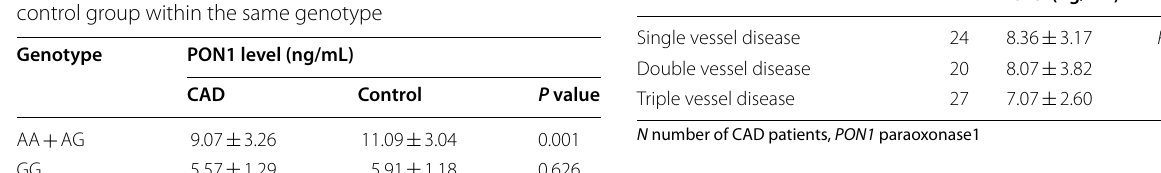
standard deviation, PON1 paraoxonase1 ±